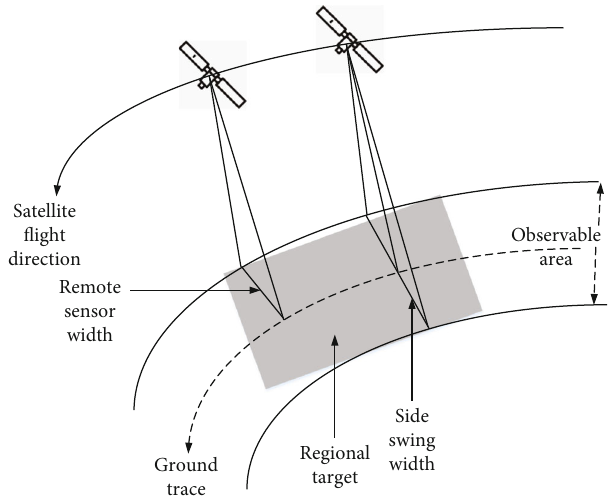
Figure 6: Joint observation of polygon